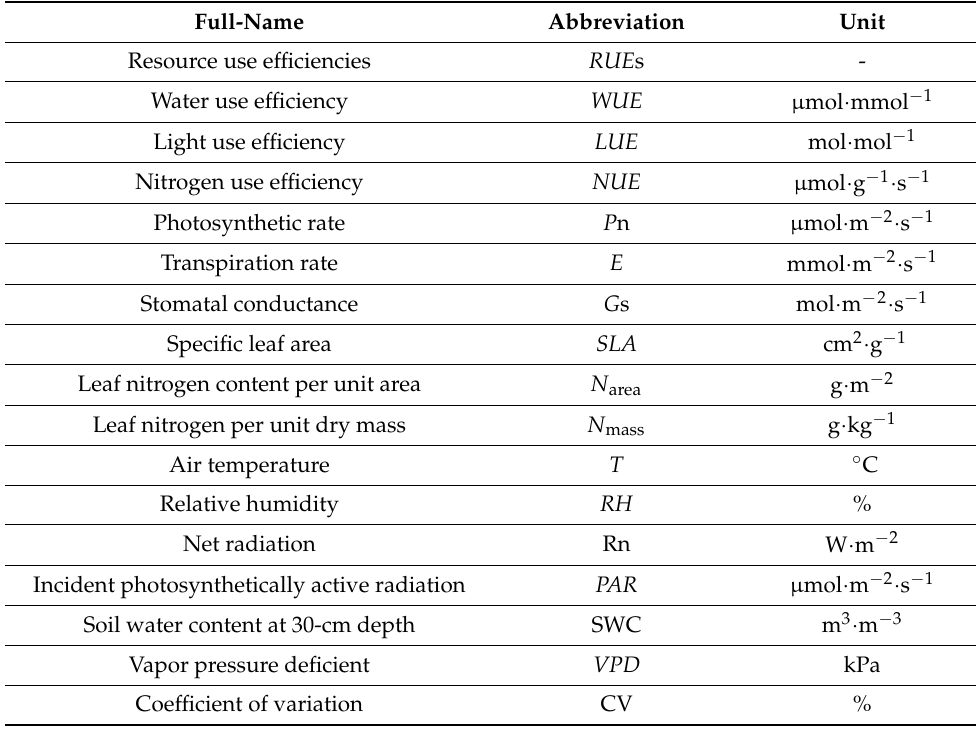
Table A1. Acronyms addressed in this study and their units of